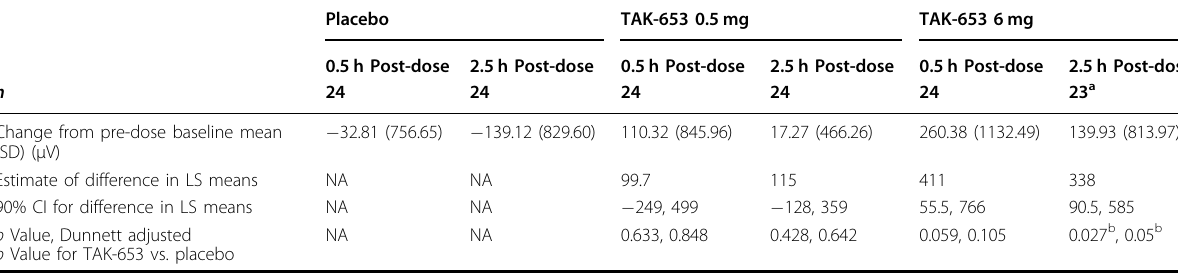
Table 3 Single-pulse peak-to-peak amplitude.